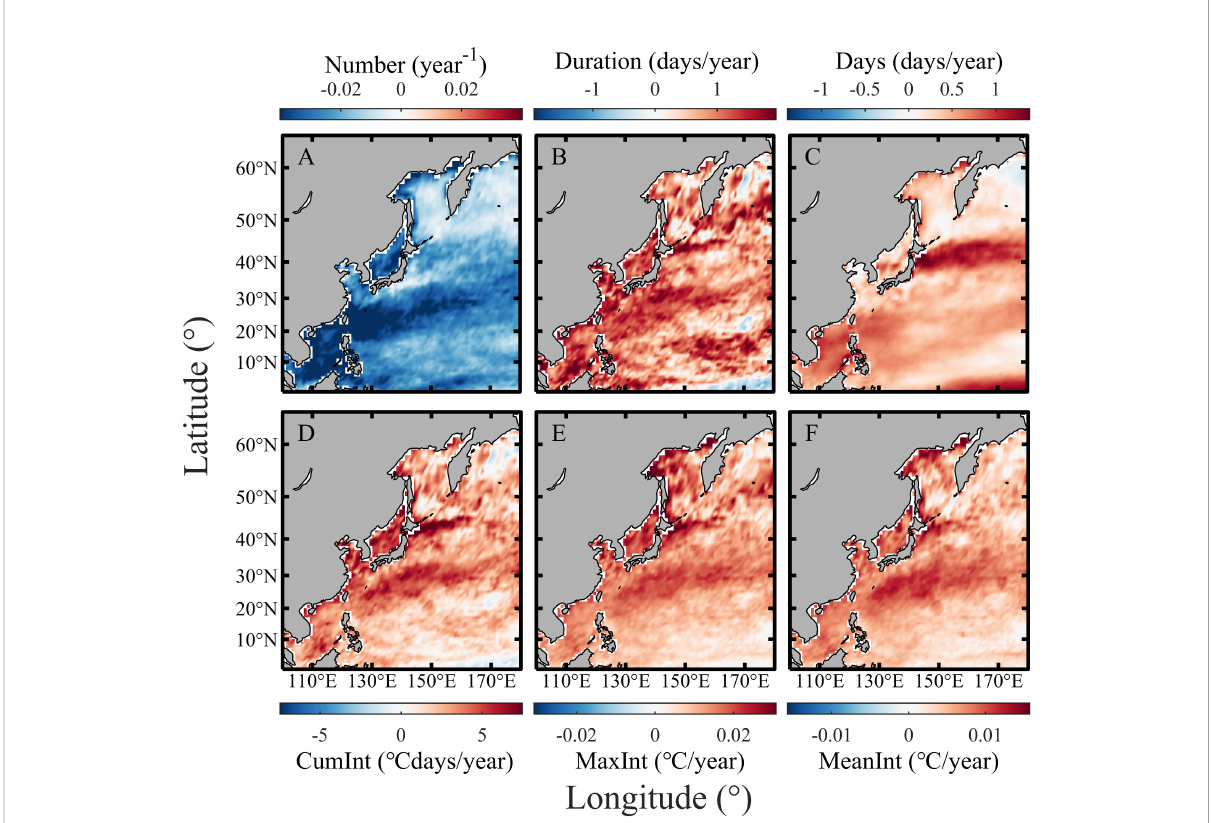
FIGURE 12 Spatial distribution of differences in projected annual variation ratio of MHWs characteristics for the SSP2-4.5 and 5-8.5 (SSP5-8.5 minus SSP2- 4.5). Average annual variation ratio differences for MHWs (A) Number (units: year -1 ), (B) Duration (units: day/year), (C) Days (units: day/year), (D) CumInt (units: °Cdays/year), (E) MaxInt (units: °C/year), and (F) MeanInt (units: